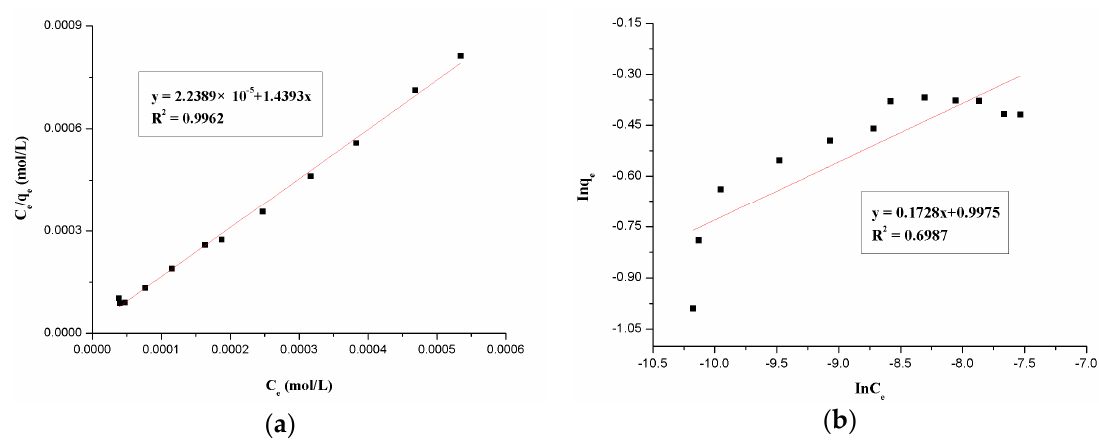
Figure 10. Adsorption isotherms of Langmuir model ( a ) and Freundlich model ( b ).